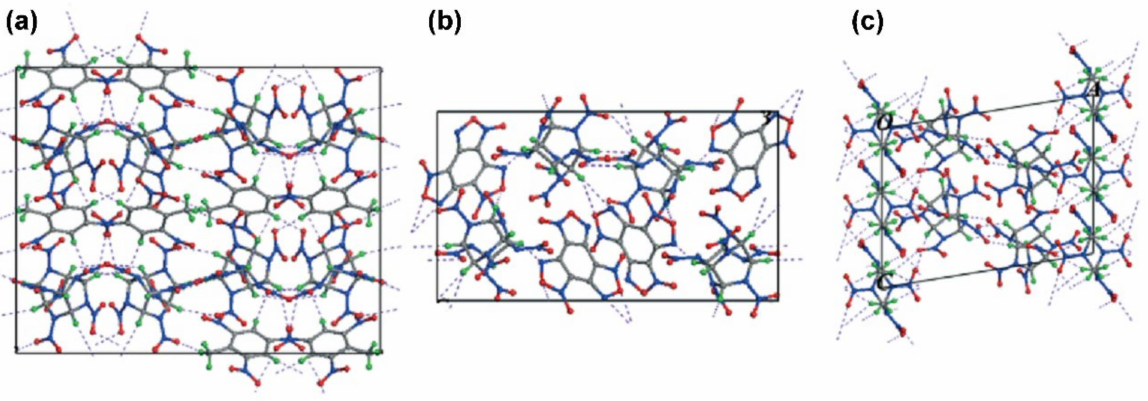
Figure 5. Intermolecular hydrogen bonds in CL-20-based cocrystals (represented by purple dashes). ( a ) CL-20/TNT, ( b ) CL-20/BTF, and ( c ) CL-20/HMX. The carbon, hydrogen, oxygen, and nitrogen atoms are represented in grey, green, red, and blue, respectively. Reproduced from [61]. Copyright 2015, The Royal Society of